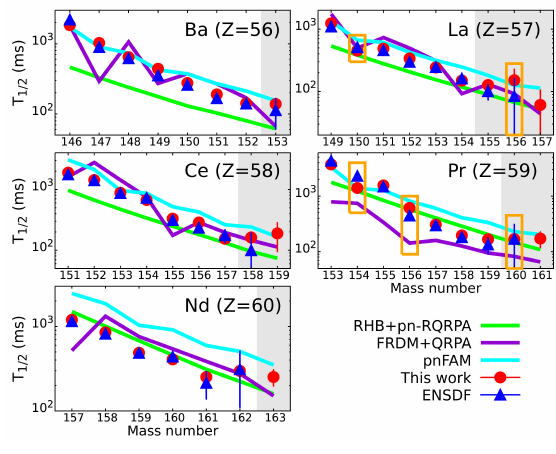
Figure 3. (Color online) Preliminary half-lives derived in this work (red circles) and previous measurements (blue triangles). These results are compared to three theoretical models: RHB + pn-RQRPA [13] (green), FRDM + QRPA [4] (purple), and pnFAM [14] (light-blue). The grey region highlights expected improvements in the determination of T 1 / 2 by the end of the data analysis. Potential isomer contributions are indicated by orange boxes